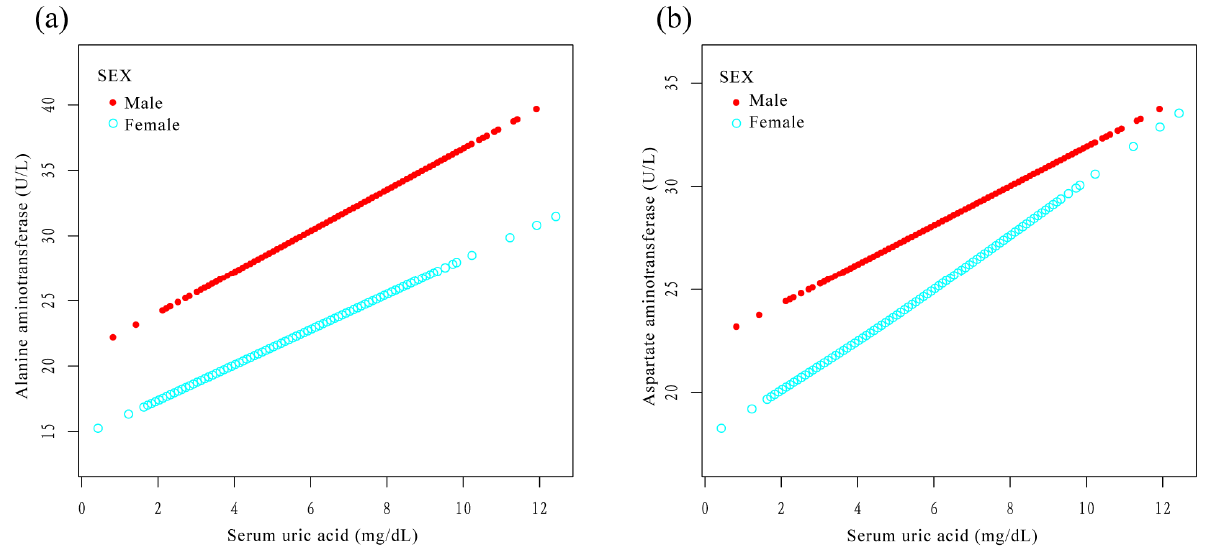
Figure 5. Relationship between serum uric acid and liver enzymes stratified by sex. The lines represent fitted curves. ( a ) Relationship between serum uric acid and alanine aminotransferase stratified by sex (R 2 = 0.149). ( b ) Relationship between serum uric acid and aspartate aminotransferase stratified by sex (R 2 = 0.077).